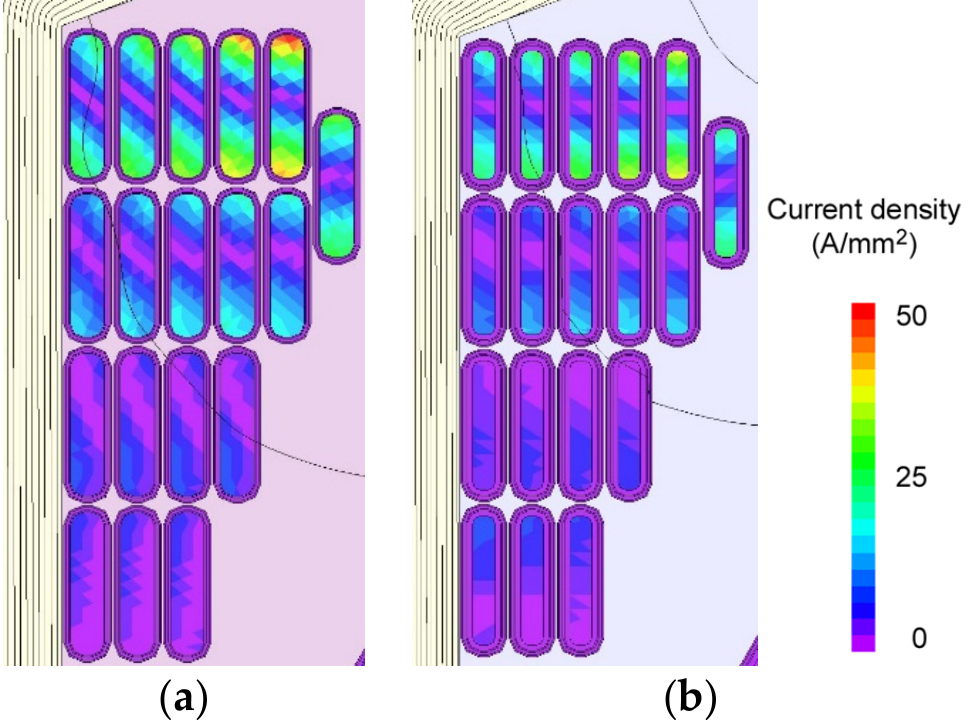
Figure 10. Distributions of current density. ( P o = 10 kW, N r = 10,000 rpm, θ e = 69 ◦ ) ( a ) rectangular winding; ( b ) magnetic tape-wrapped winding.